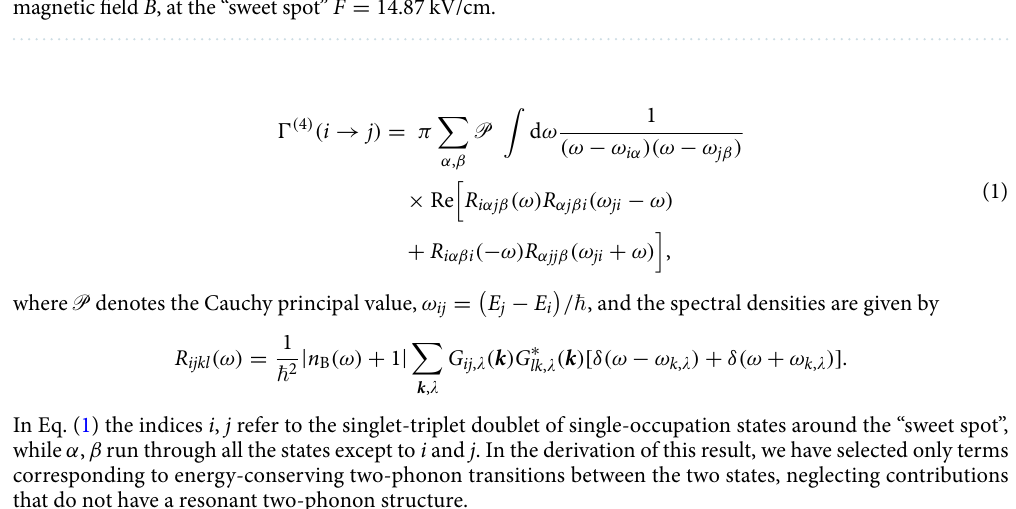
Figure 4. Energy branches ( a ) and phonon-assisted relaxation rates at T magnetic field B , at the “sweet spot” F